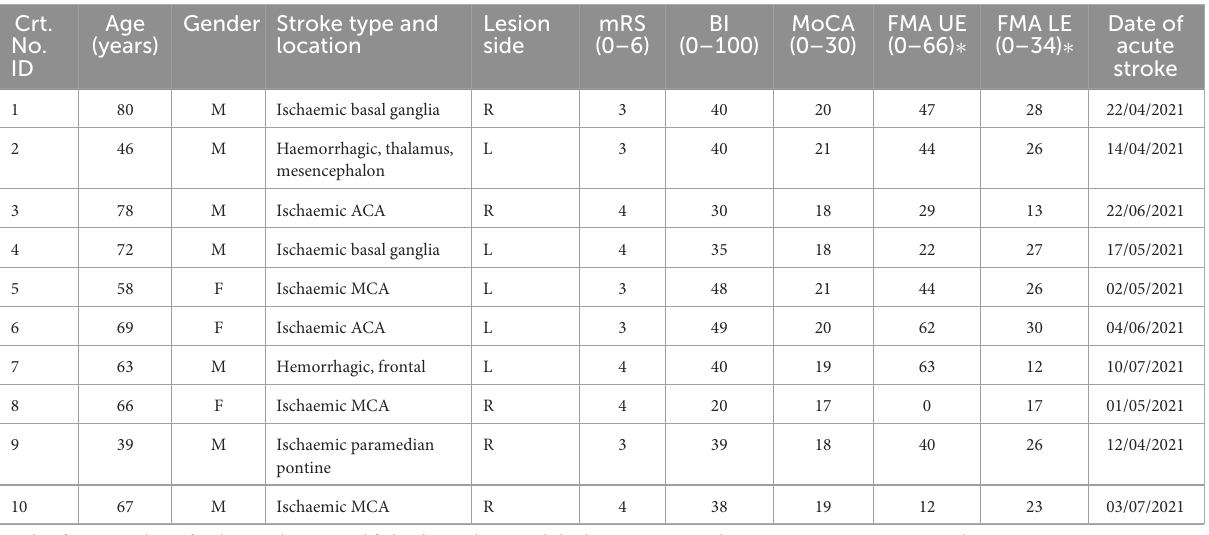
TABLE 1 The characteristics of the sample included in the clinical validation study—ID, identification. Crt.